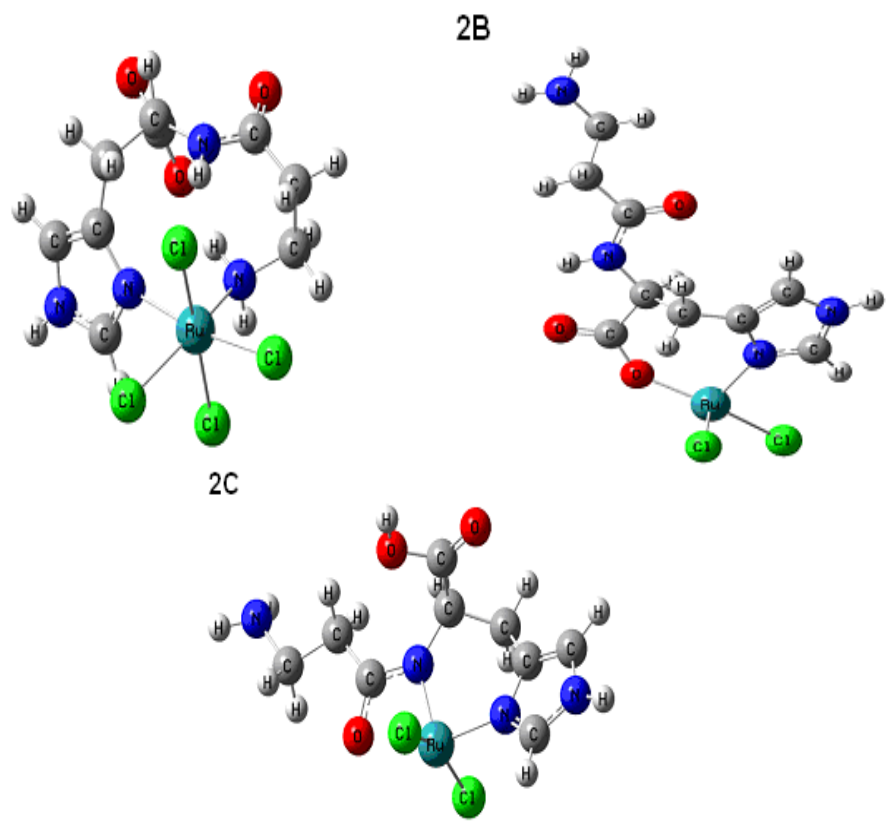
Figure 9. Low energy conformations of different proposed structures for Ru-carnosine